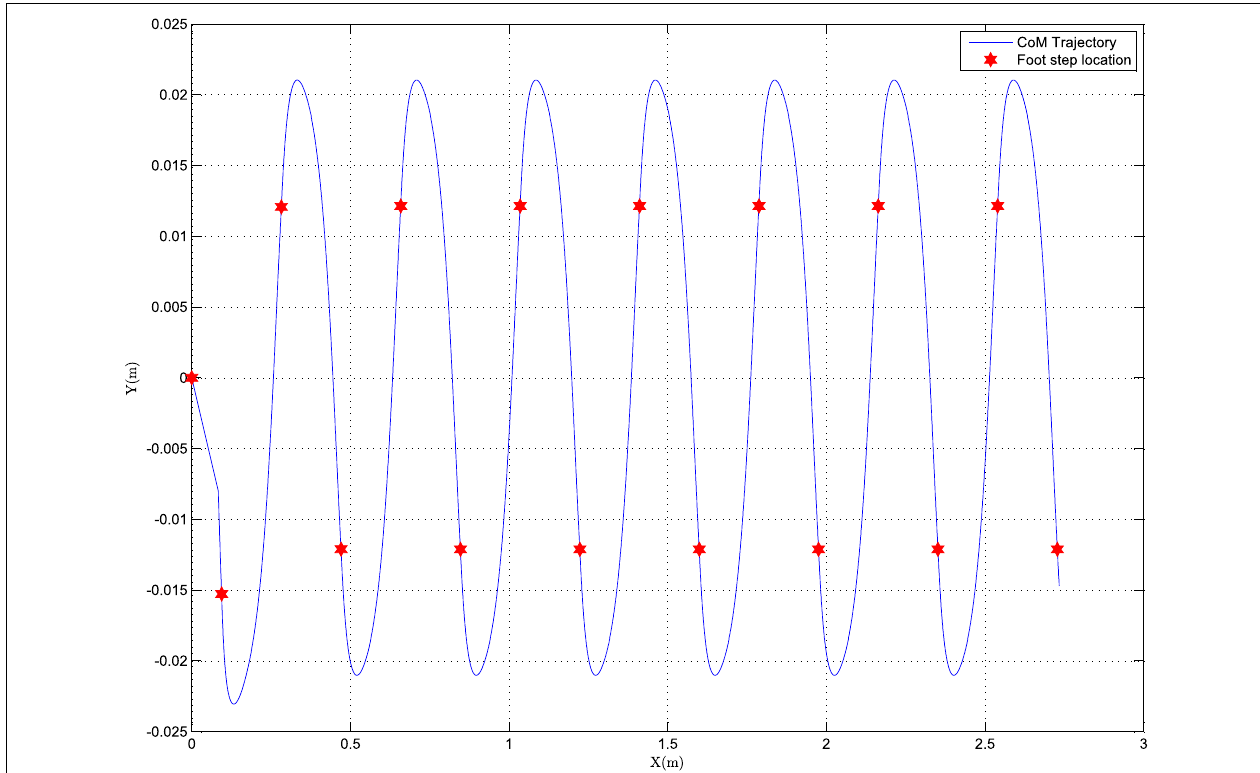
FIGURE 10 | Top view of the CoM motion as a result of the simulation of the gait generation and control method for a number of steps . The foot locations are also shown highlighting the support exchange from one foot to the next.